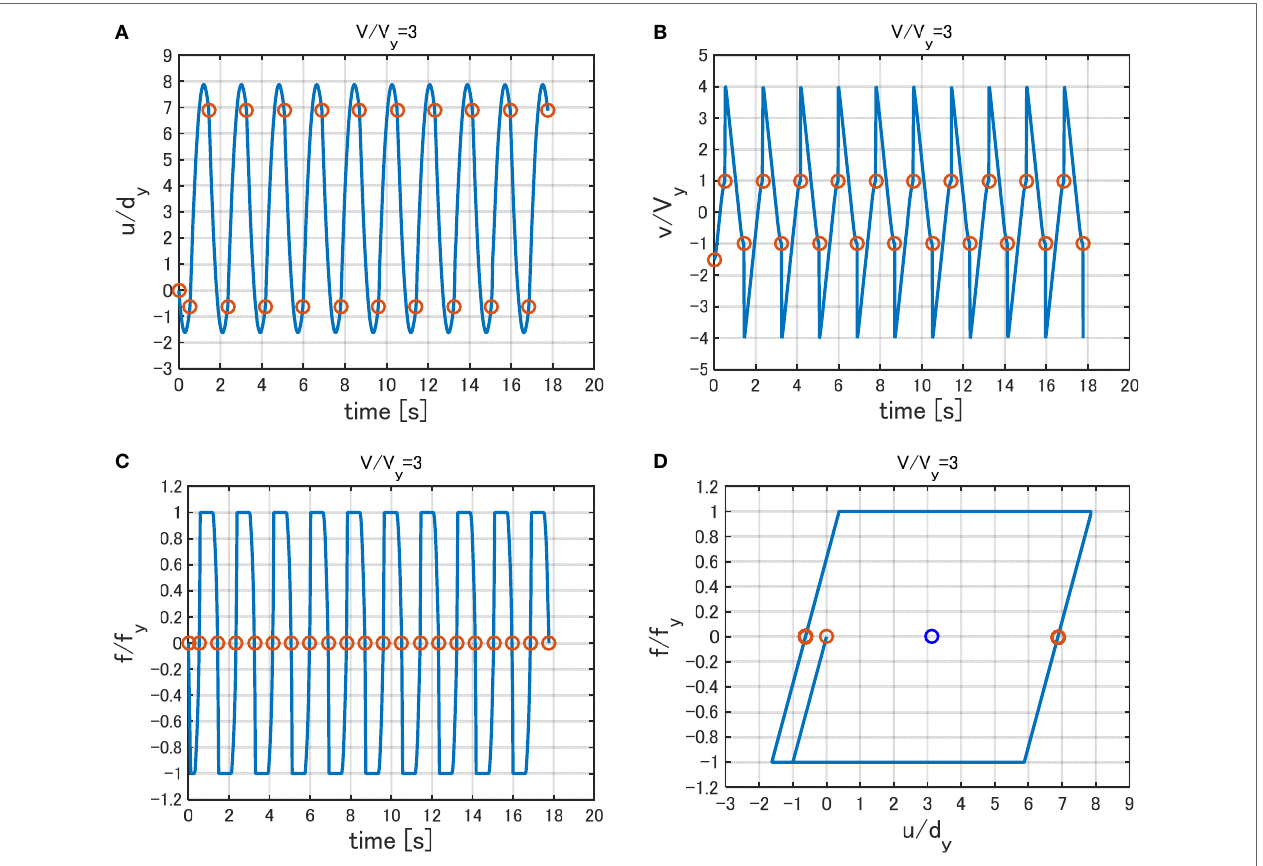
FigUre 11 | response to input sequence 2 for V / V y = 3: (a) displacement, (B) velocity, (c) restoring force, and (D) force–deformation relation .